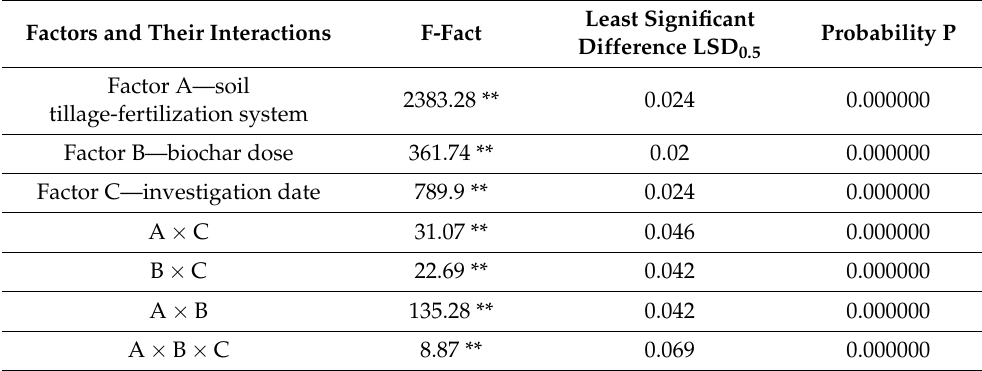
Table 3. Variance analysis of soil pH, n = 3.